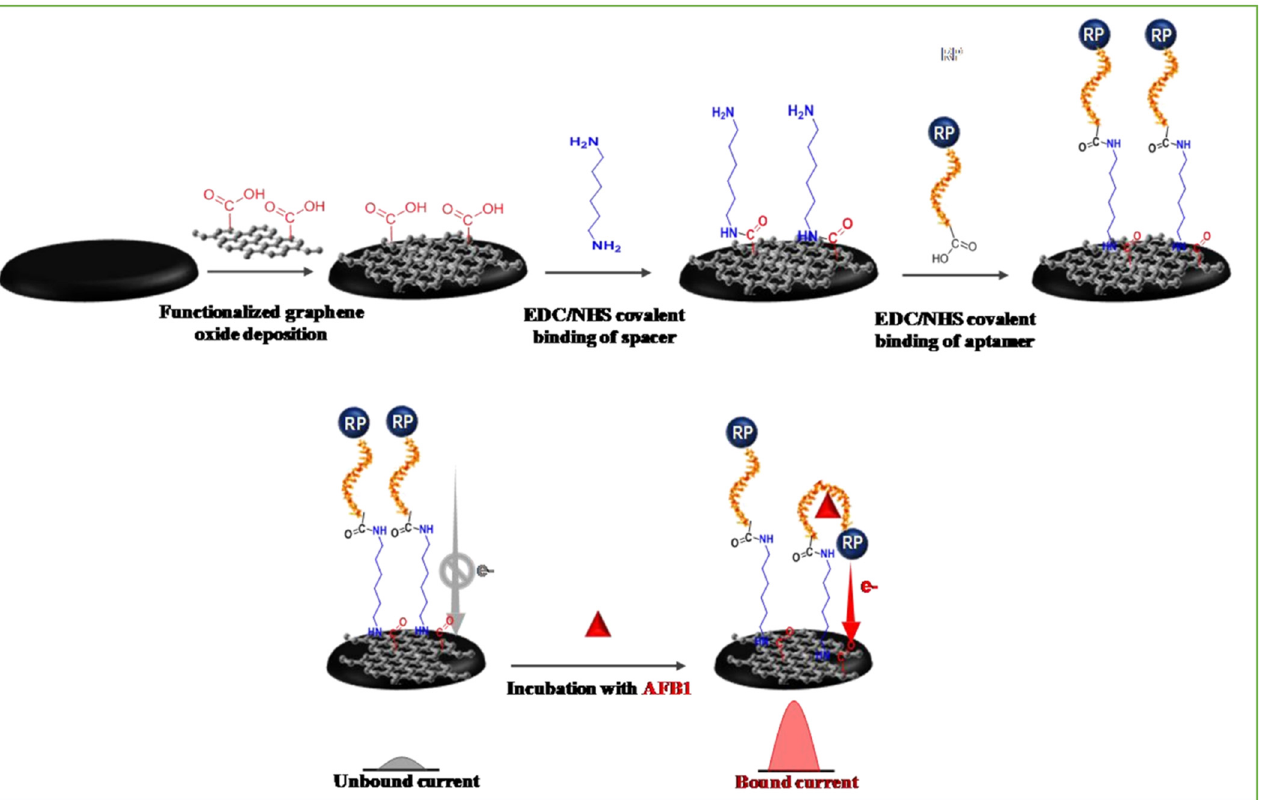
Figure 3. Schematic representation of the electrode fabrication and principle of the developed molecular folding-based aptasensor. Reprinted with permission from [32]. Copyright 2017 Elsevier.